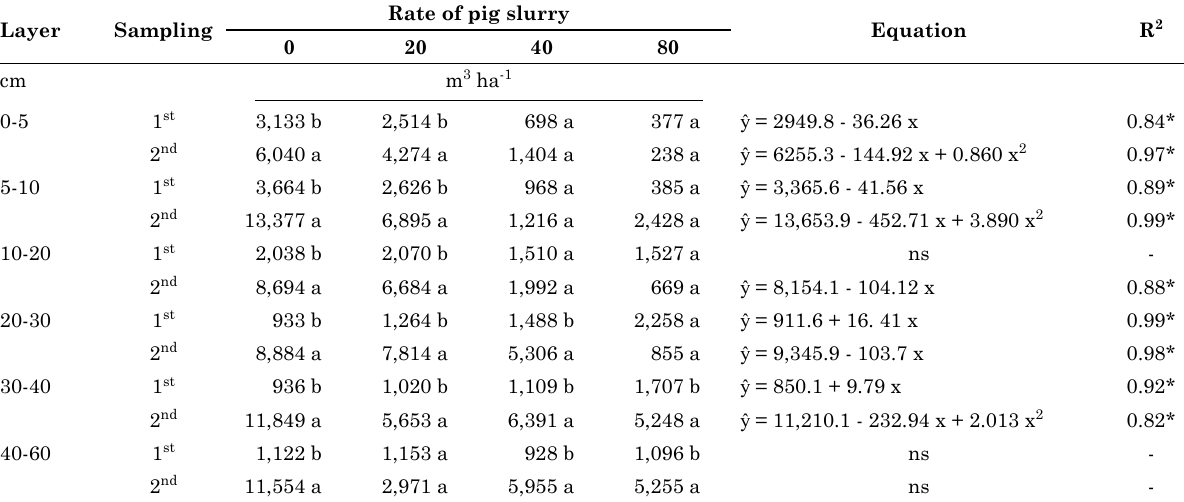
Table 2. Distribution coefficients (K d ) between the solid phase and the solution in the 1 st and 2 nd sampling in a typic hapludalf soil treated with 0, 20, 40, and 80 m 3 ha -1 of pig slurry layer